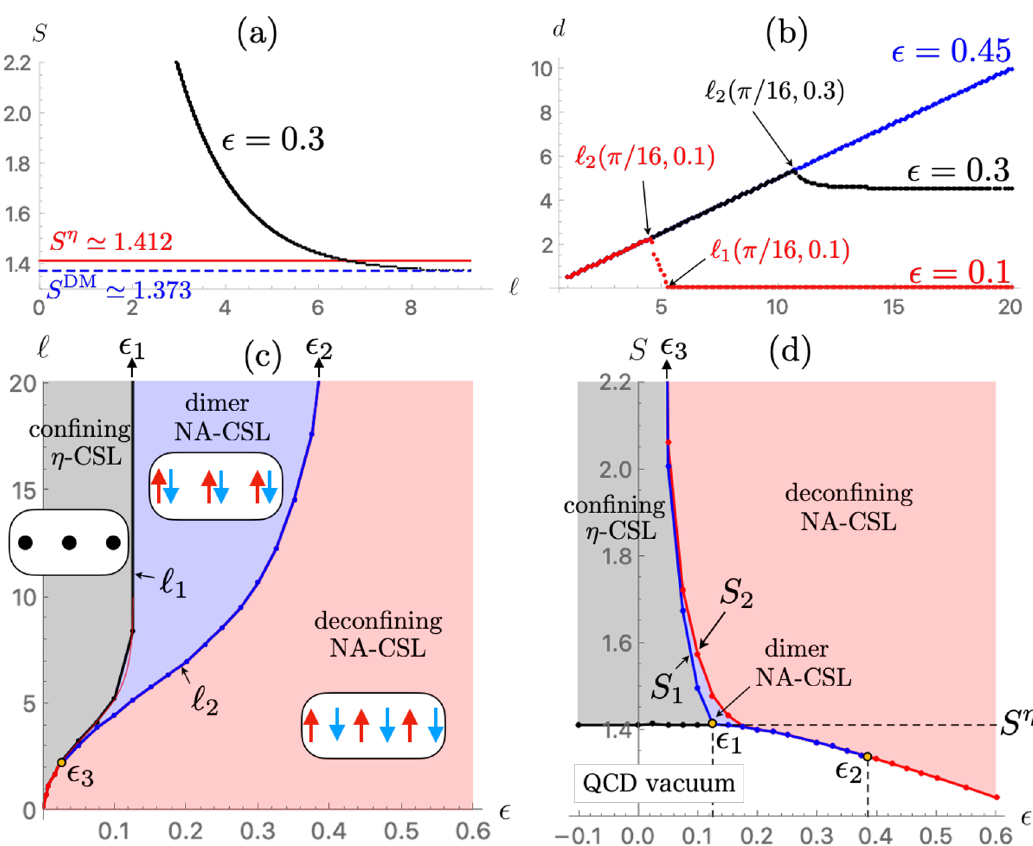
Figure 3 . CSLs for β = π/ 16 . (a) Relation ‘ ( S ) is shown for (cid:15) = 0 . 3 . ‘ diverges at S = S DM ( < S η ) . (b) Distance d between u- and d-CSs is shown as a function of ‘ for (cid:15) = 0 . 1 , 0 . 3 , and 0 . 45 . Points on the line d = ‘/ 2 correspond to the deconfined NA-CSL, the dimer NA-CSL ( d 6 = 0 ), or the η -CSL ( d = 0 ). (c) CSL phase diagram in the (cid:15) - ‘ plane. The array of arrows represents the antiferro-isospin chain of the NA-CSL, while that of black dots represents the η -CSL (isoscalar). The thin-red-solid curve corresponds to the border of the η -CSL linear stability for β = π/ 16 , given in figure 2(a). (d) CSL phase diagram in the (cid:15) - S plane. In (c) and (d), (cid:15) 1 , 2 , 3 correspond to the three tricritical